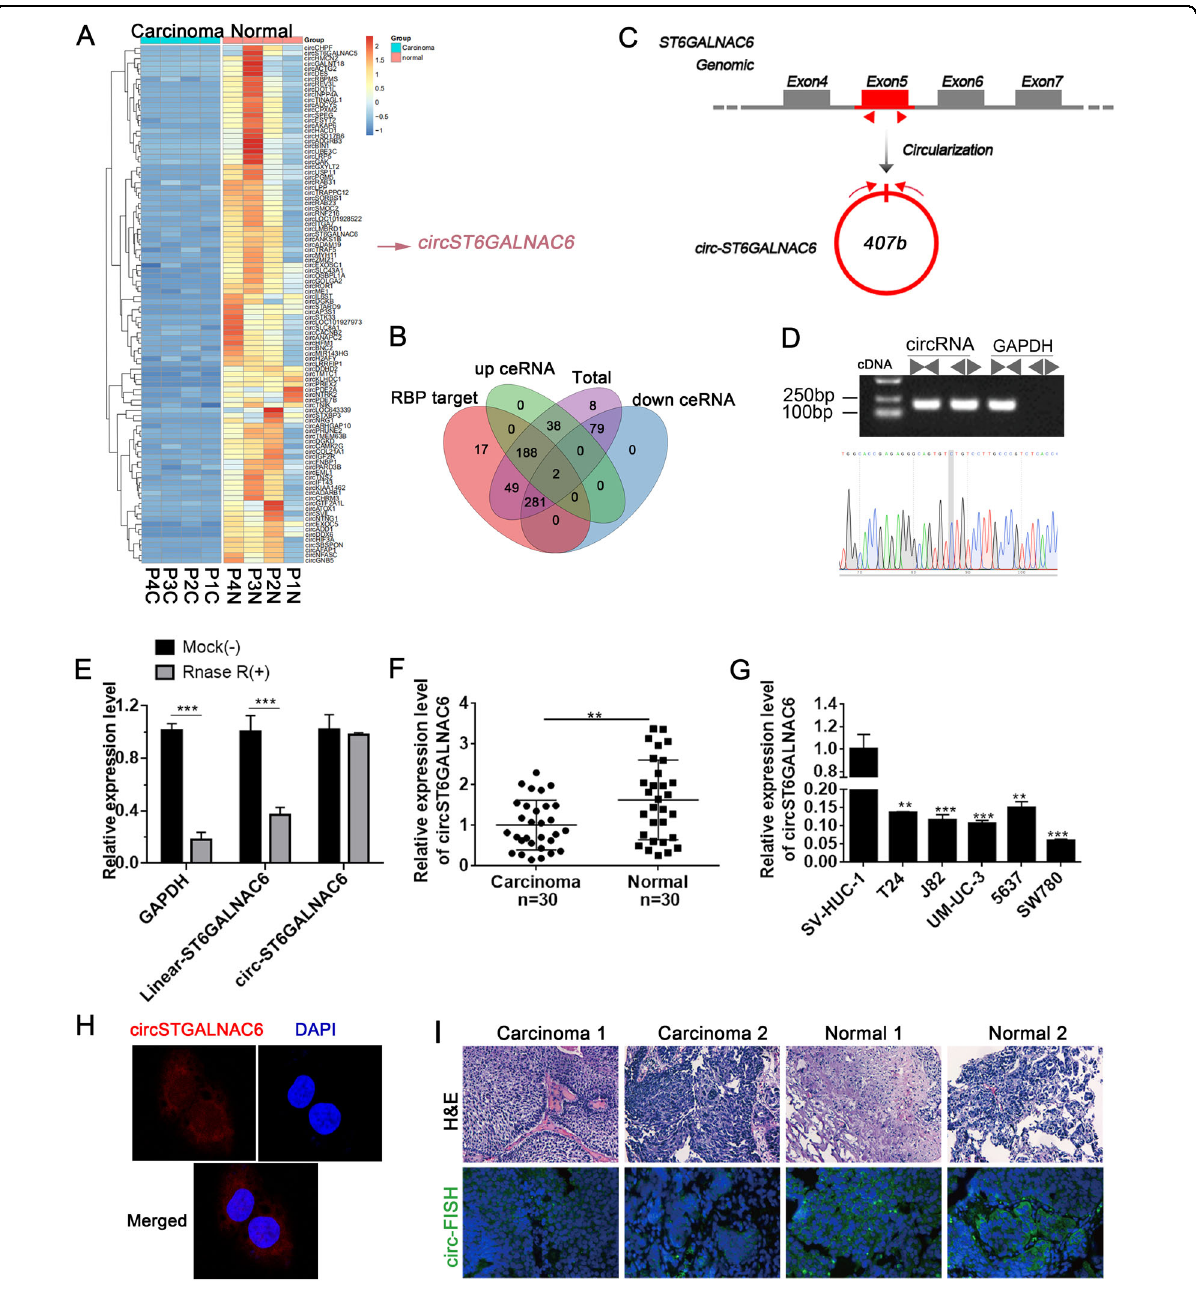
Fig. 1 CircST6GALNAC6 is downregulated in bladder cancer tissues and cells. A Heatmap exhibiting the top 100 downregulated circRNAs, which are displayed on a scale from blue (small change) to orange (large change), between four bladder cancer (BCa) tissues and adjacent normal tissues from 4 human patients. B Schematic illustration shows the number of circRNAs that bind with RBPs or miRNAs. C Schematic representation of circST6GALNAC6 formation. D Gel electrophoresis shows that circST6GALNAC6 can be ampli fi ed by divergent primers using total cDNA. Sanger sequencing validates its splicing junction. GAPDH served as a control. E CircST6GALNAC6 resistance to Rnase R was determined by qRT-PCR assay. GAPDH served as an endogenous control. F , G circST6GALNAC6 expression was analysed by qRT-PCR in 30 BCa tissues and 5 BCa cells (T24, J82, UM- UC-3, 5637 and SW780) and compared with 30 adjacent normal tissues and a normal human uroepithelial cell line (SV-HUC-1), respectively. H , I Representative images of H&E staining ( H ) and FISH staining ( I ) to analyse circST6GALNAC6 levels in two BCa tissues (Carcinoma 1/2) and normal tissues. G FISH assay was conducted to detect the expression distribution of circST6GALNAC6 in UM-UC-3 cells. *** P < 0.001 and ** P <